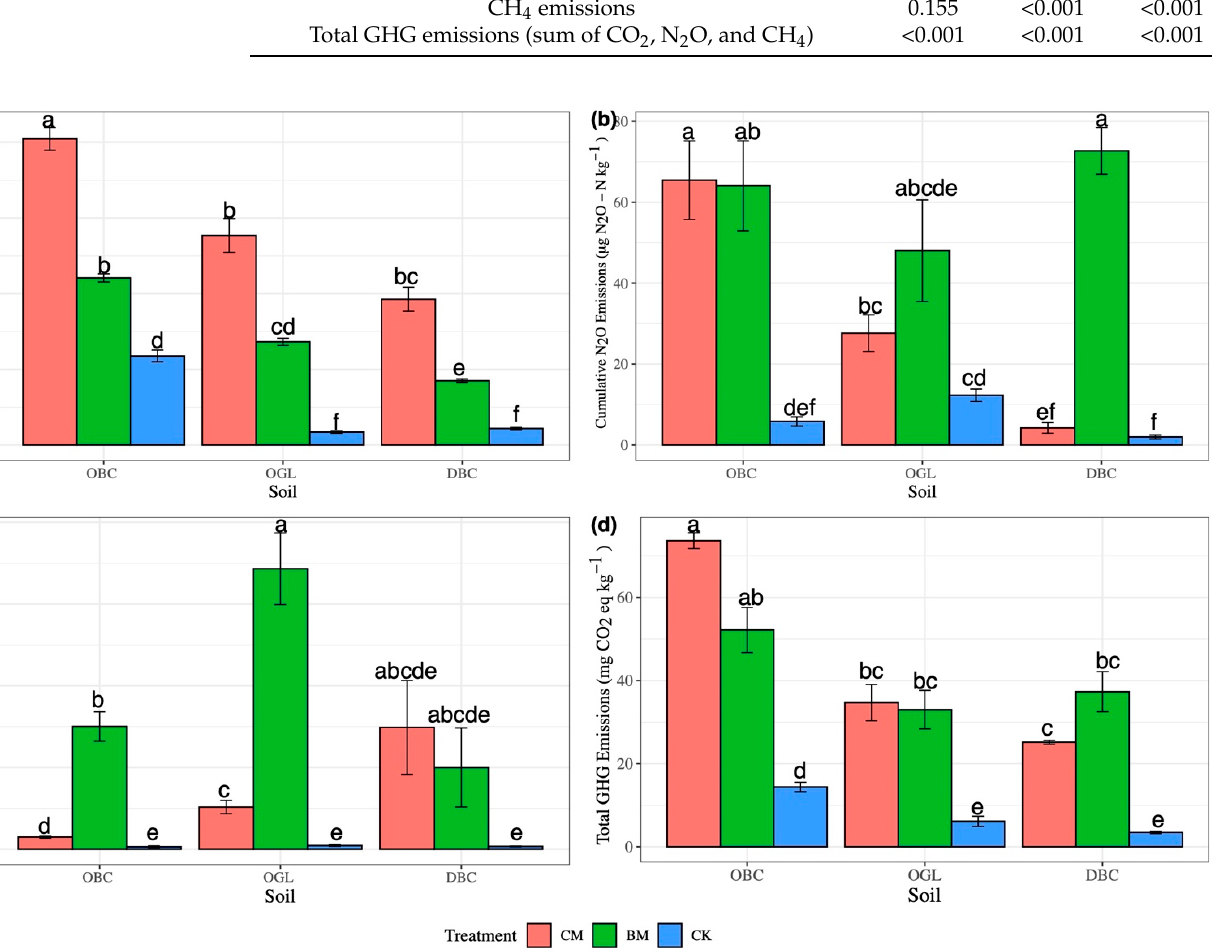
Figure 1. Effects of manure type on cumulative ( a ) CO 2 , ( b ) N 2 O, ( c ) CH 4 , and on ( d ) total GHG emissions (sum of CO 2 , N 2 O, and CH 4 ) across three soil types. Soil type: OBC, Orthic Black Chernozem; OGL, Orthic Gray Luvisol; and DBC, Dark Brown Chernozem. Manure type: CM, manure from cattle fed a corn silage-based backgrounding diet; BM, manure from cattle fed a barley silage-based backgrounding diet; and CK, control (soil without amendments). The letters denote significant differences across soils and treatments, with columns that do not share the same letter being significantly different from each other ( α = 0.05). Vertical bars indicate standard errors of the means ( n = 4).